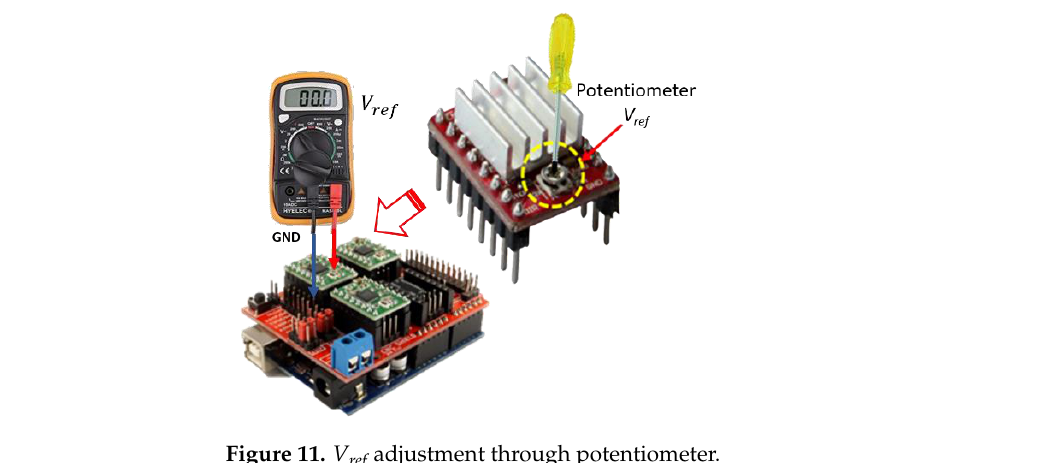
Figure 11. V ref adjustment through potentiometer.